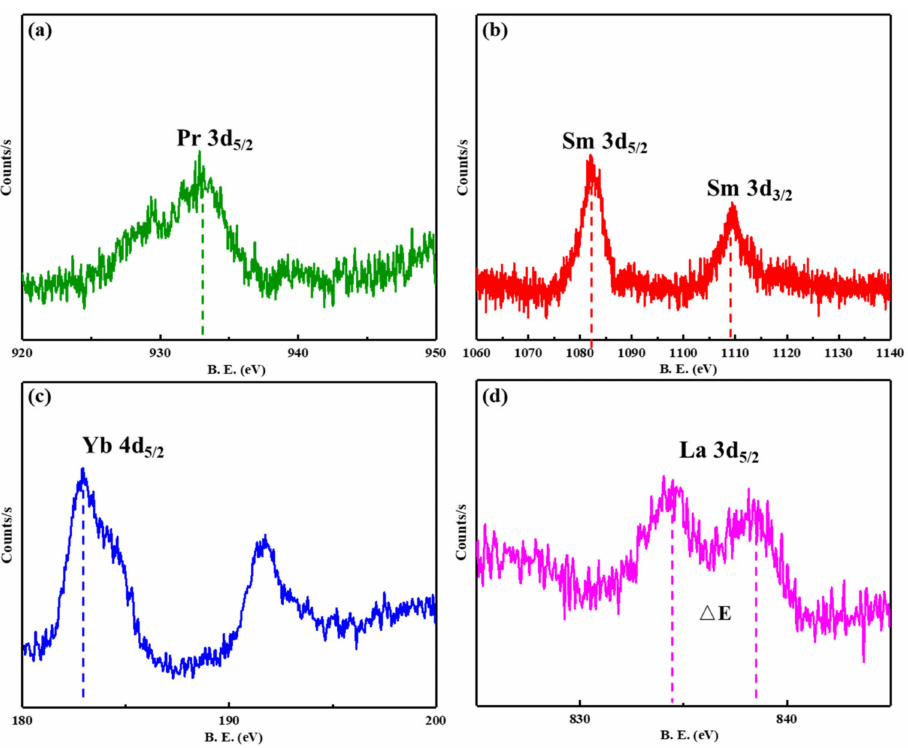
Figure 8. XPS spectra of ( a ) Pr 3d, ( b ) Sm 3d, ( c ) Yb 4d and ( d ) La 3d of the 15Ni2R/M-Ce80Zr20 (R = La, Sm, Pr, Yb)